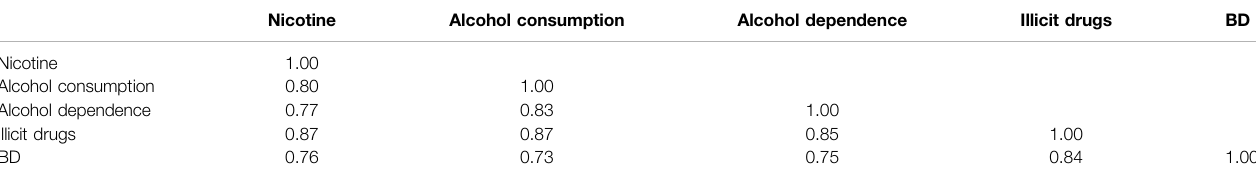
TABLE 2 | Spearman ’ s rank correlation coef fi cients among the fi ve clinical phenotypes ( N =